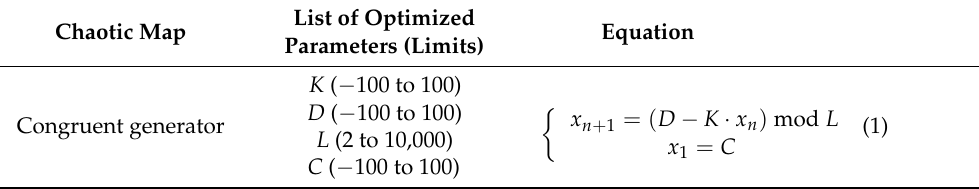
Table 3. Chaotic map equation and list of optimized parameters with limits. List of Chaotic Map